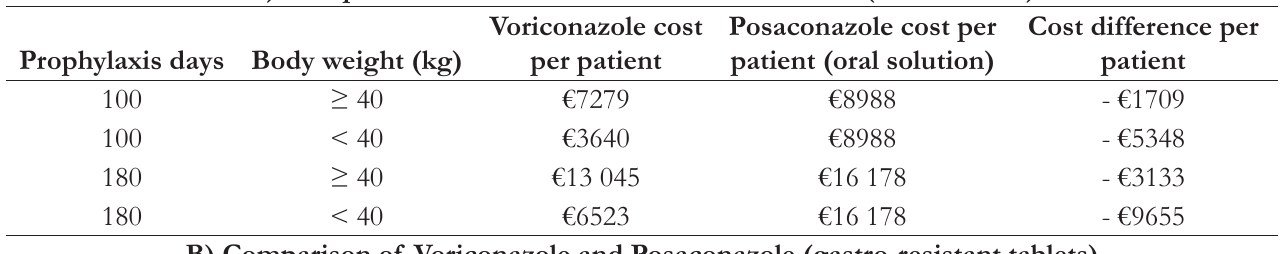
Table 2. Non-modeled Costs Analysis